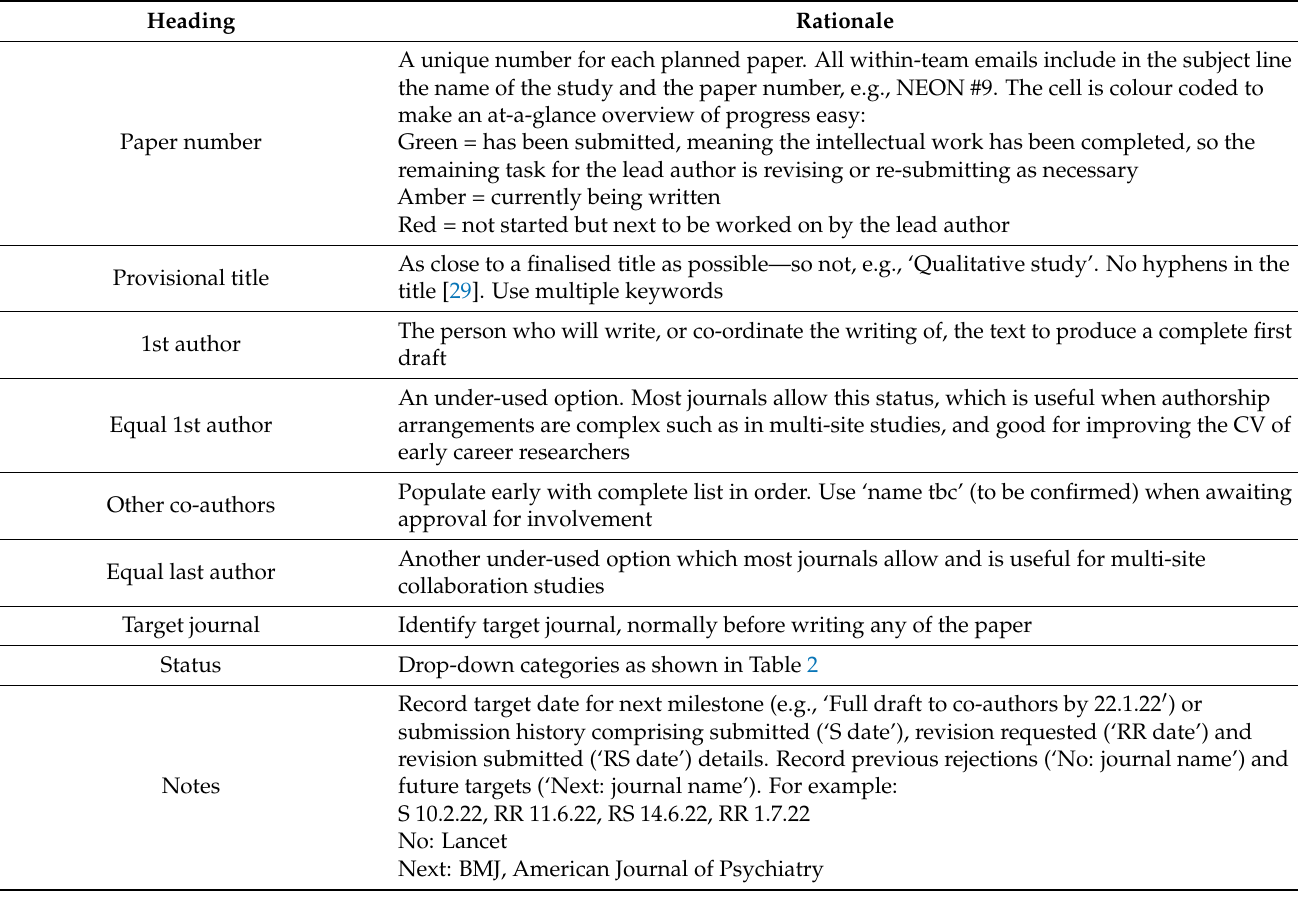
Table 1. Planned Journal worksheet headings in study publications plan.